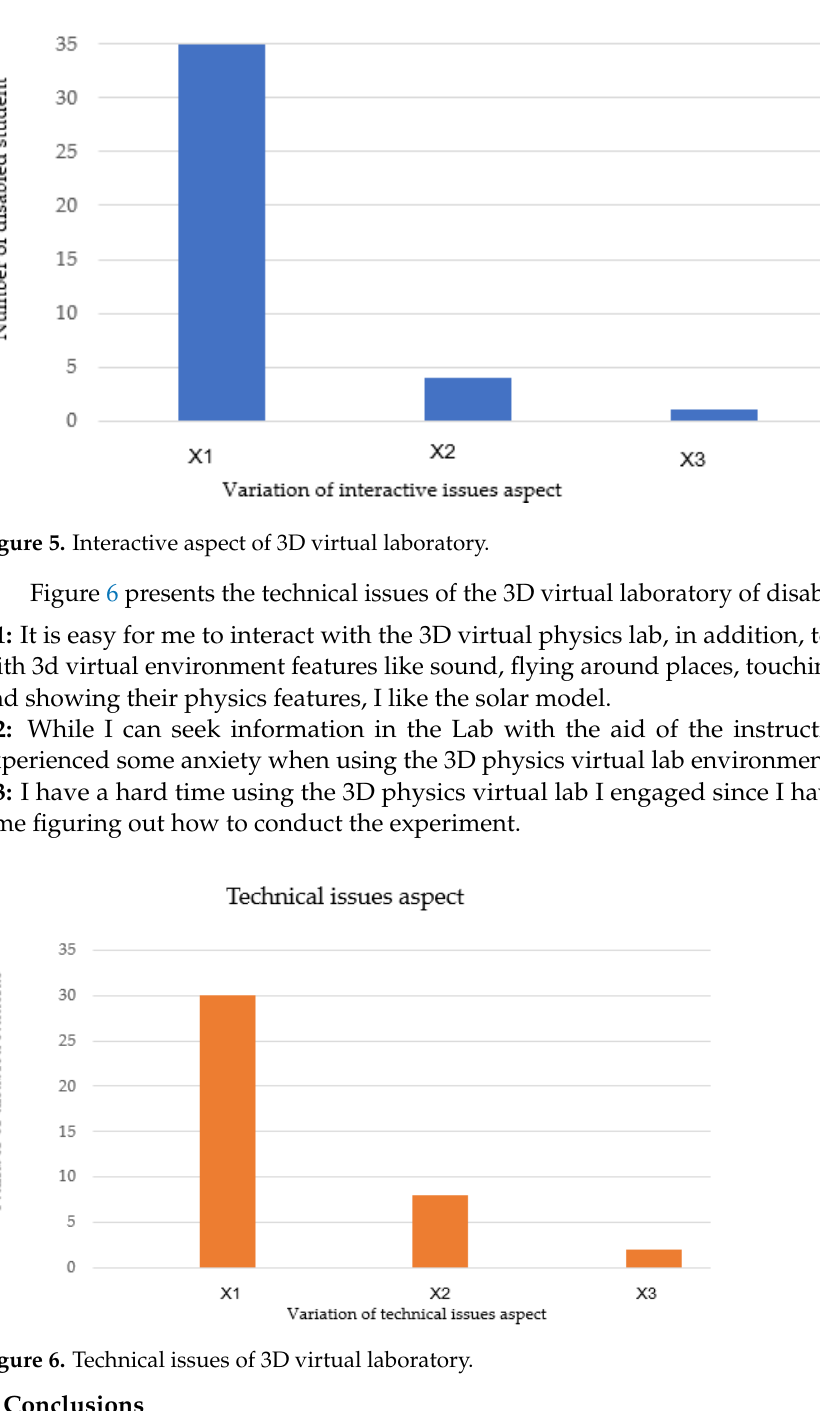
Figure 6. Technical issues of 3D virtual laboratory.